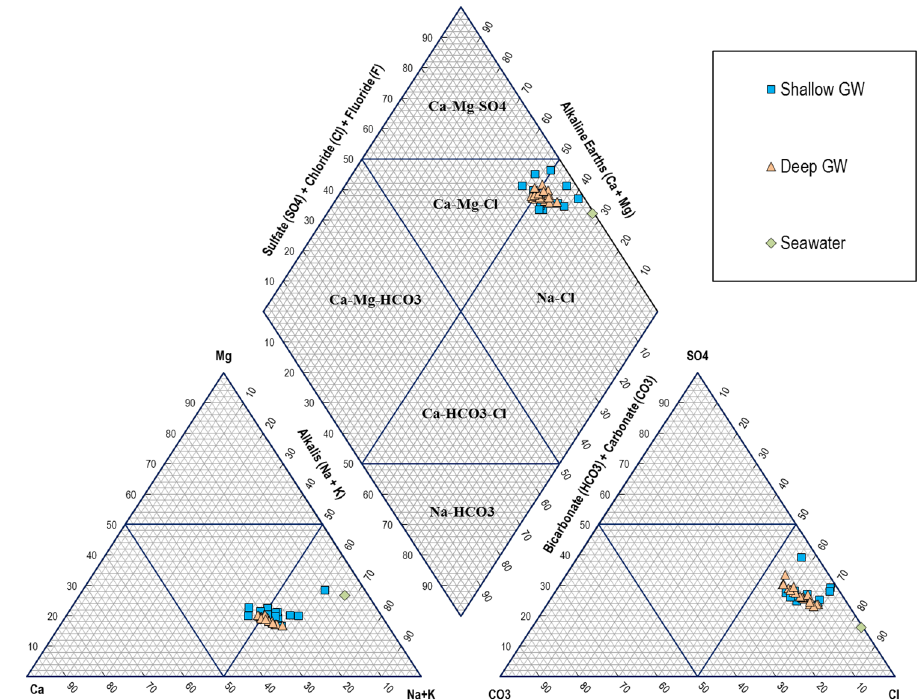
Figure 8. Piper diagram showing the hydrochemical facies of tested GW samples.